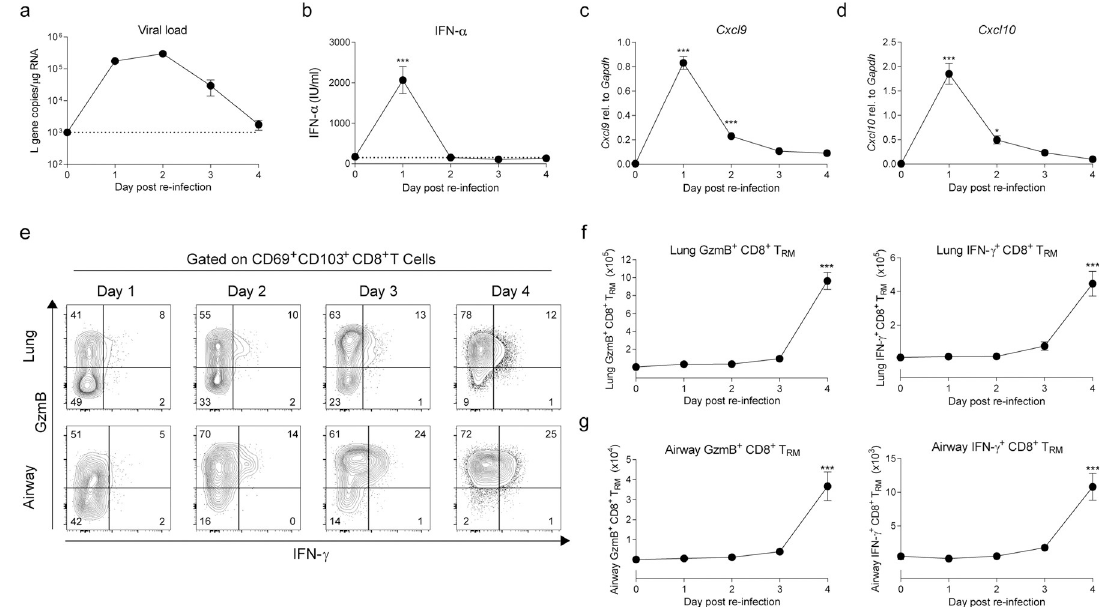
Fig 2. Inflammatory mediators during RSV-mediated CD8 + T RM cell re-activation. Mice were RSV infected i.n. and three weeks p.i. mice were mock or re-challenged with RSV and lung and airways samples were analyzed at different time points (day 0 = mock re- infection) ( a ) Lung viral load determined by RT-qPCR quantification of RSV L gene expression in lung tissue. ( b ) IFN- α levels in BAL fluid analyzed by ELISA. mRNA expression of ( c ) Cxcl9 and ( d ) Cxcl10 was quantified by RT-qPCR in lung tissue. Lung and airway cells were stimulated with RSV M 187-195 peptide and IFN- γ and GzmB production was detected by intracellular staining and quantified in CD8 + T RM cells using flow cytometry. ( e ) Representative flow cytometry plots of IFN- γ and GzmB intracellular staining in CD8 + CD69 + CD103 + T RM cells. Total number of IFN- γ and GzmB positive CD8 + CD69 + CD103 + T RM cells in ( f ) lung tissue and ( g ) airways. Data are presented as the mean ± SEM of 9–11 individual mice per time point, pooled from two independent experiment. Statistical significance of differences between day 0 (mock re-infection) and other time points was determined by one-way ANOVA with Tukey’s post hoc test. � indicates differences between day 0 and days 1–4. � P � 0.05, �� P � 0.01, ��� P �